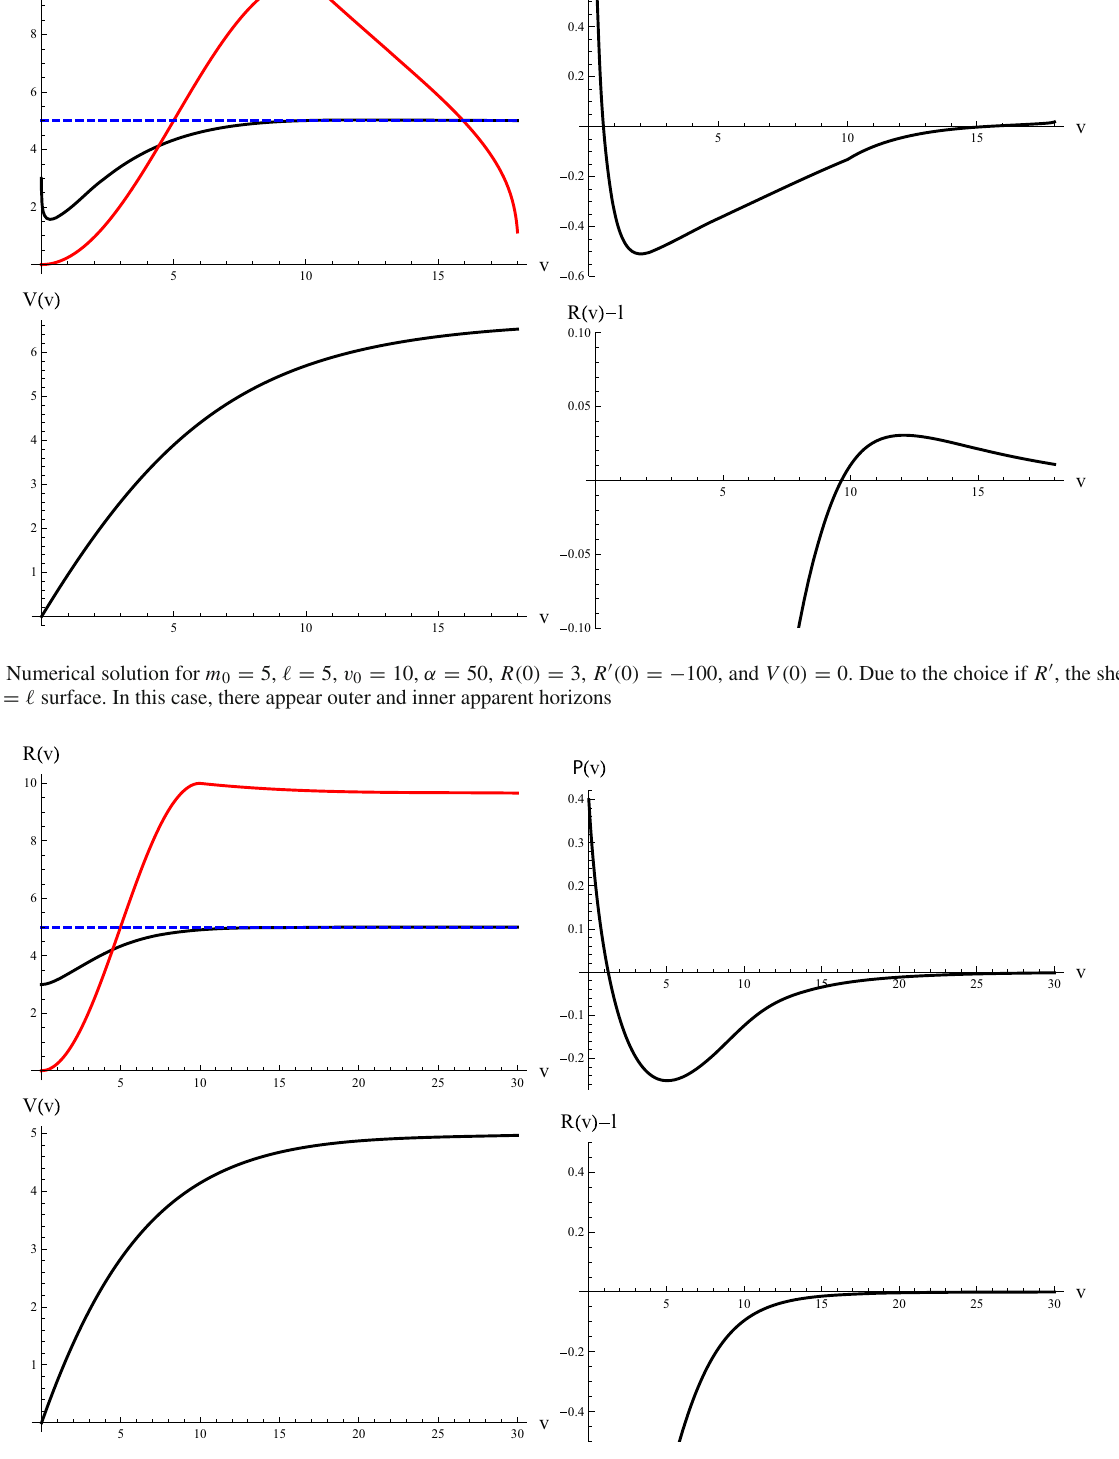
Fig. 3 Numerical solution for m 0 = 5, (cid:3) = 5, v 0 = 10, α = 5, R ( 0 ) = 3, R (cid:2) ( 0 ) = 0, and V ( 0 ) = 0. The other results are similar to the previous result, but now the apparent horizon is way outside the